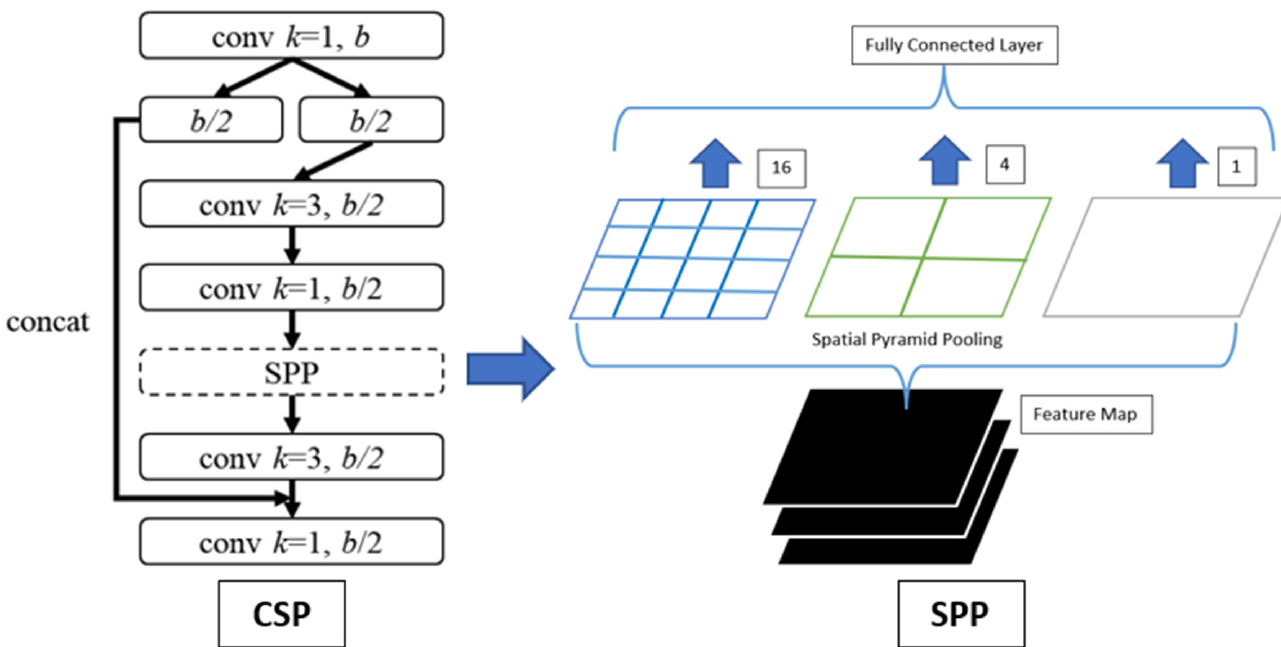
Figure 1. CSP and SPP architecture.